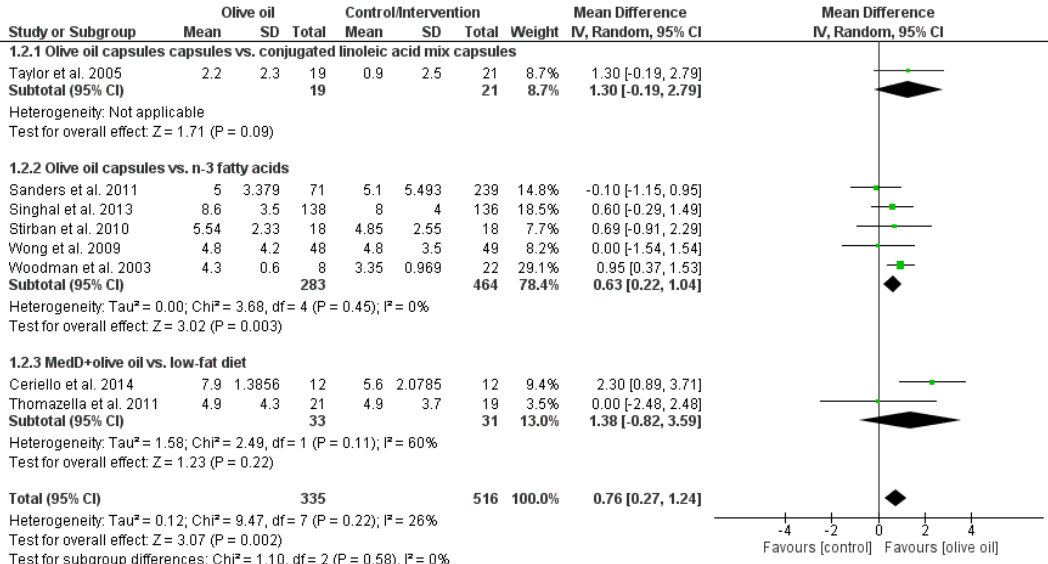
Figure 5. Effects of olive oil on flow-mediated dilatation (%, absolute percentage). Forest plot showing pooled mean differences with 95% confidence intervals (CI) for eight randomized controlled diets. For each study, the shaded square represents the point estimate of the intervention effect. The horizontal line joins the lower and upper limits of the 95% CI of these effects. The area of the shaded square reflects the relative weight of the study in the respective meta-analysis. The diamond at the bottom of the graph represents the pooled MD with the 95% CI for all study groups. Please note that the labeling of the X-axis has been switched as compared to Figures 3 and 4, respectively, since for flow-mediated dilatation an increase is considered to be favorable. MedD = Mediterranean diet.